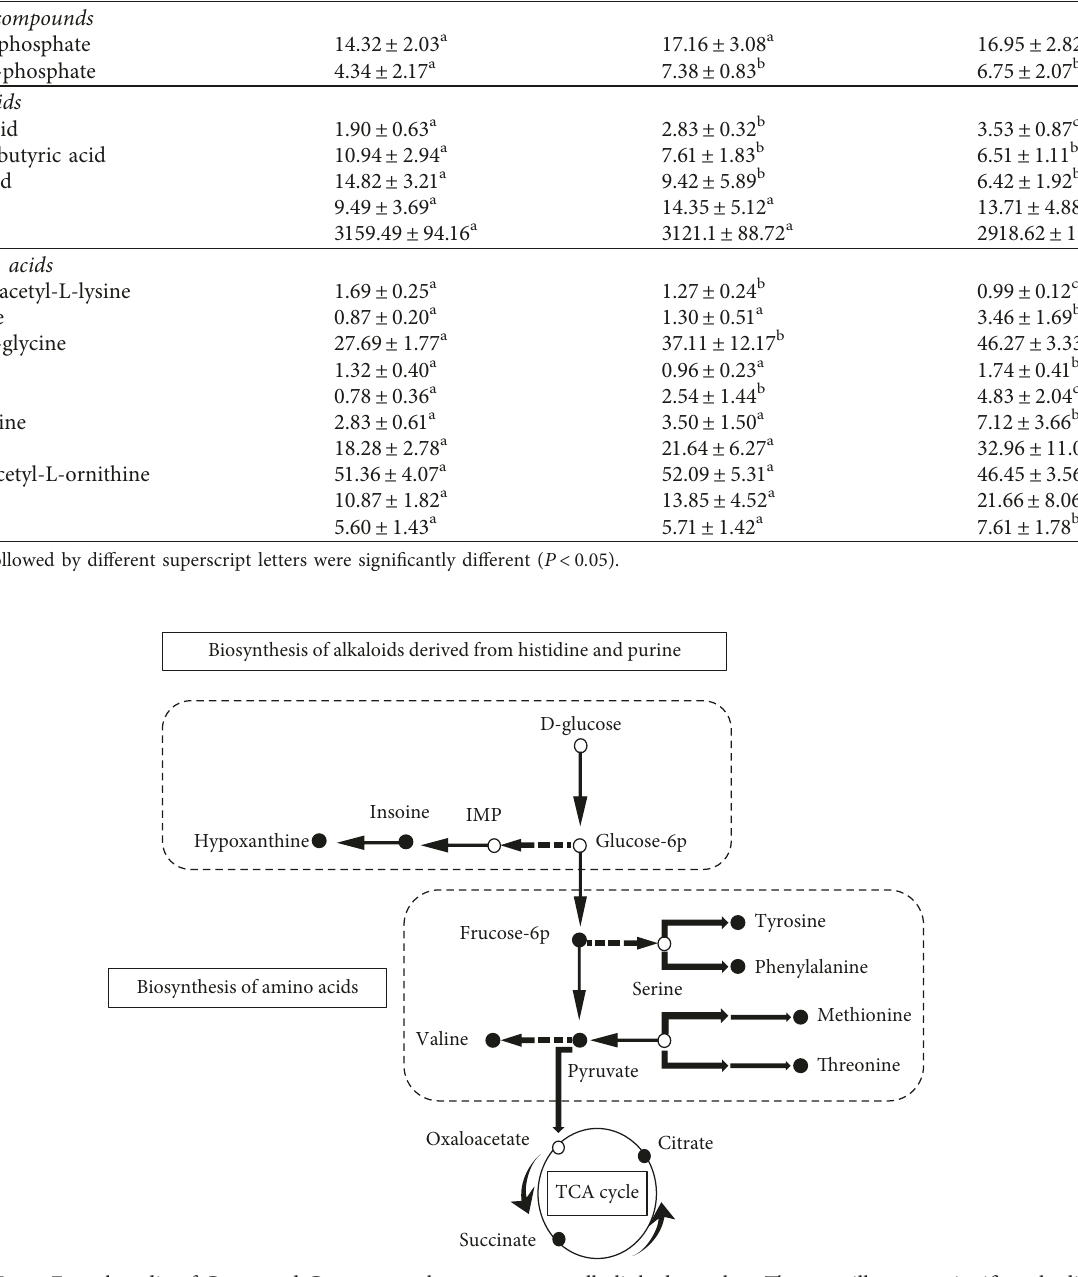
Figure 2: Kyoto Encyclopedia of Genes and Genomes pathways are manually linked together. The map illustrates significantly different metabolites in meat samples between two compared groups and three key metabolic pathways including the TCA cycle, biosynthesis of alkaloids derived from histidine and purine, and biosynthesis of amino